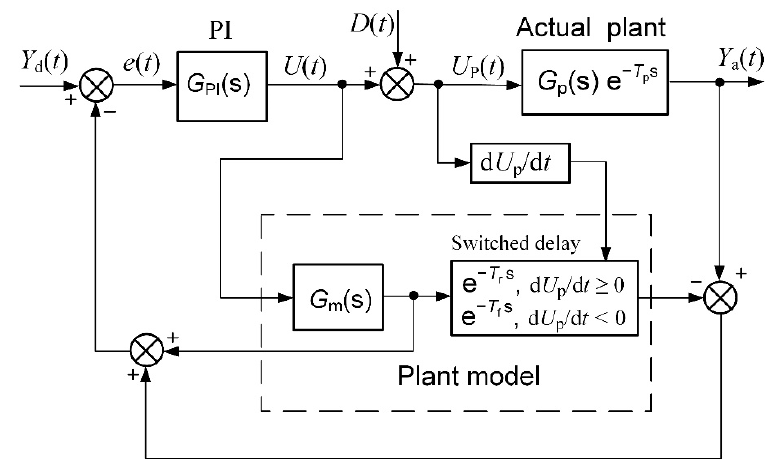
Figure 6. The block diagram of the control system based on the PI controller with the switched-delay Smith predictor.